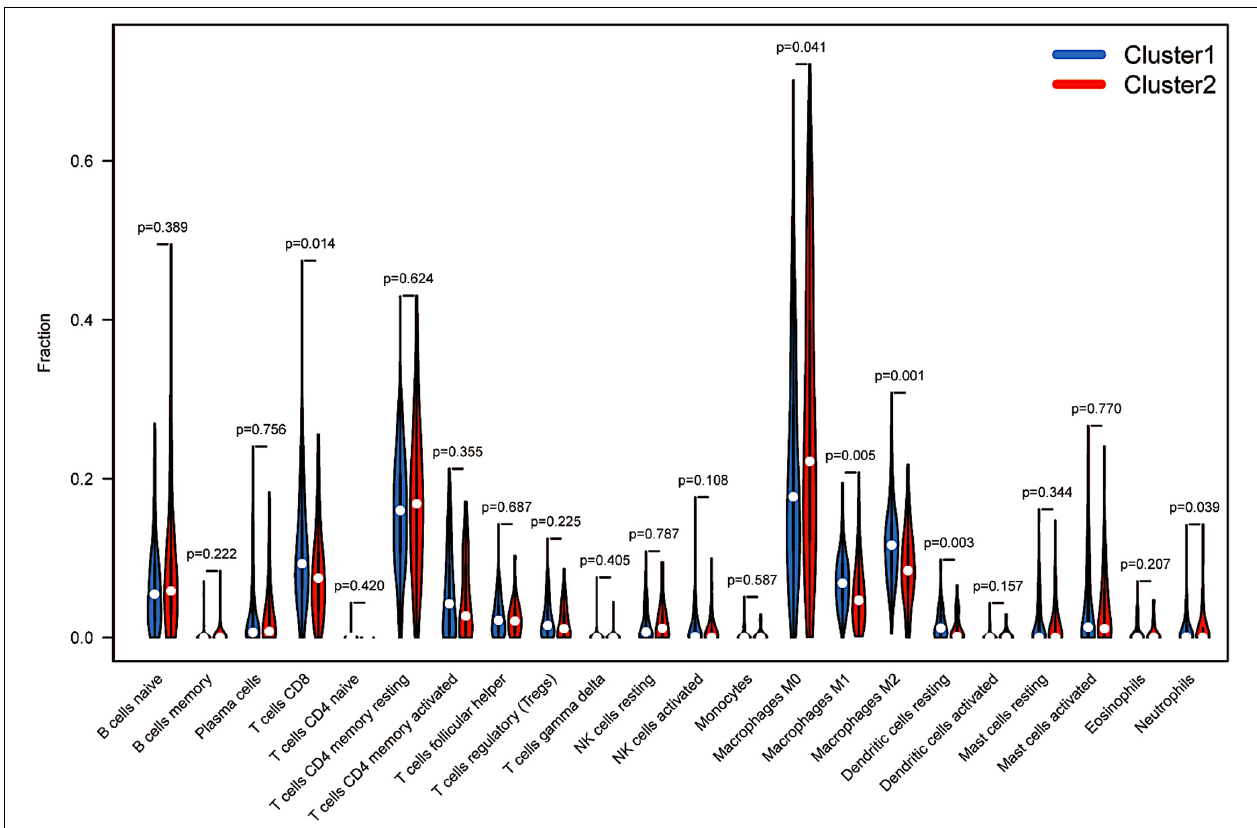
FIGURE 4 | Immunological analysis between distinct clusters. The infiltration levels of 22 immune cell types in the cluster 1/2 subtype.